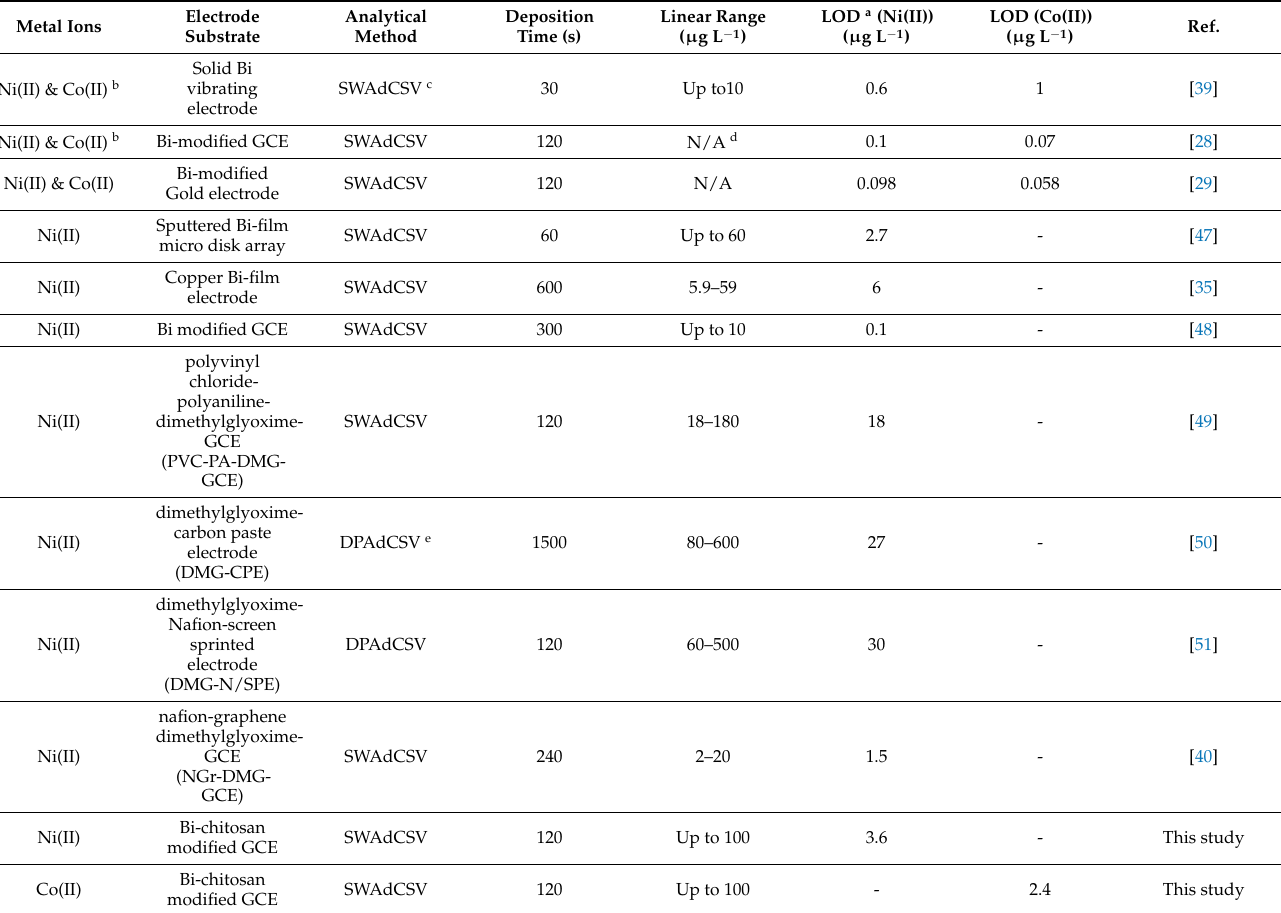
Figure 4. Characterization and evaluation of the Bi-chitosan sensor for Co(II) detection. ( a ) SWAdCSV with various Co(II) concentrations (2–100 µ g L − 1 ) and ( b ) a corresponding calibration curve. Deposition time is 120 s with a deposition potential of − 0.7 V, frequency of 60 Hz, amplitude of 50 mV, and DMG concentration of 0.2 mM. Table 1. Comparison of Ni(II) and Co(II) detection between the modified Bi-chitosan GCE sensor and other sensors previously